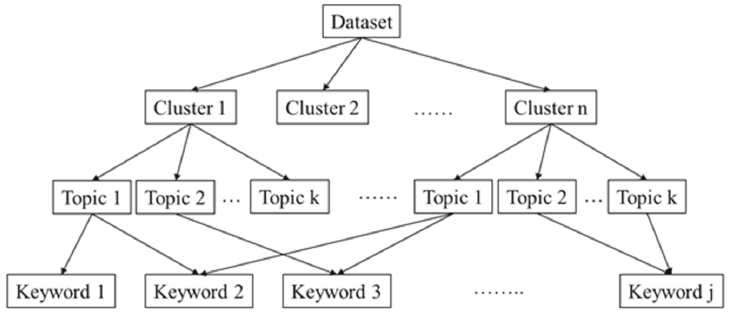
Figure 8. Ontology architecture diagram.